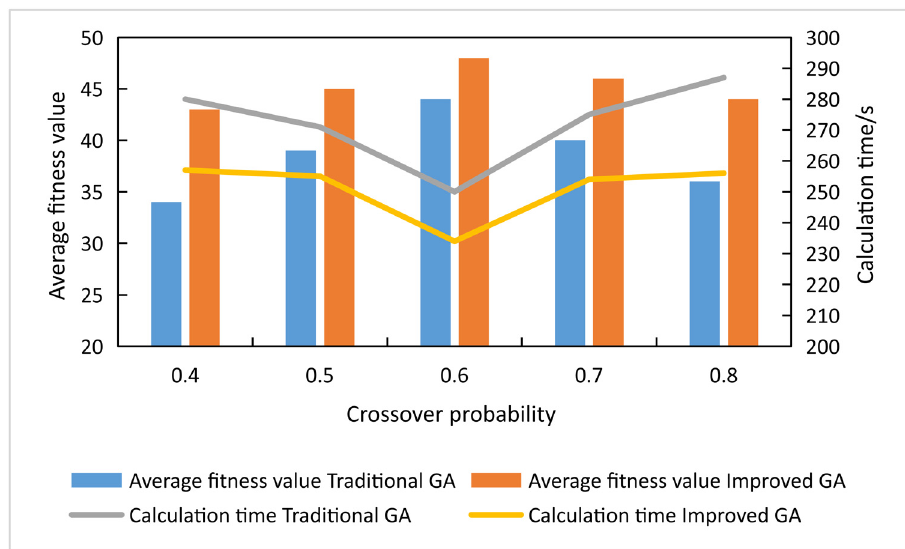
Figure 5: Performance of two genetic algorithms under di ff erent crossover probabilities when the mutation probability is 0.1.